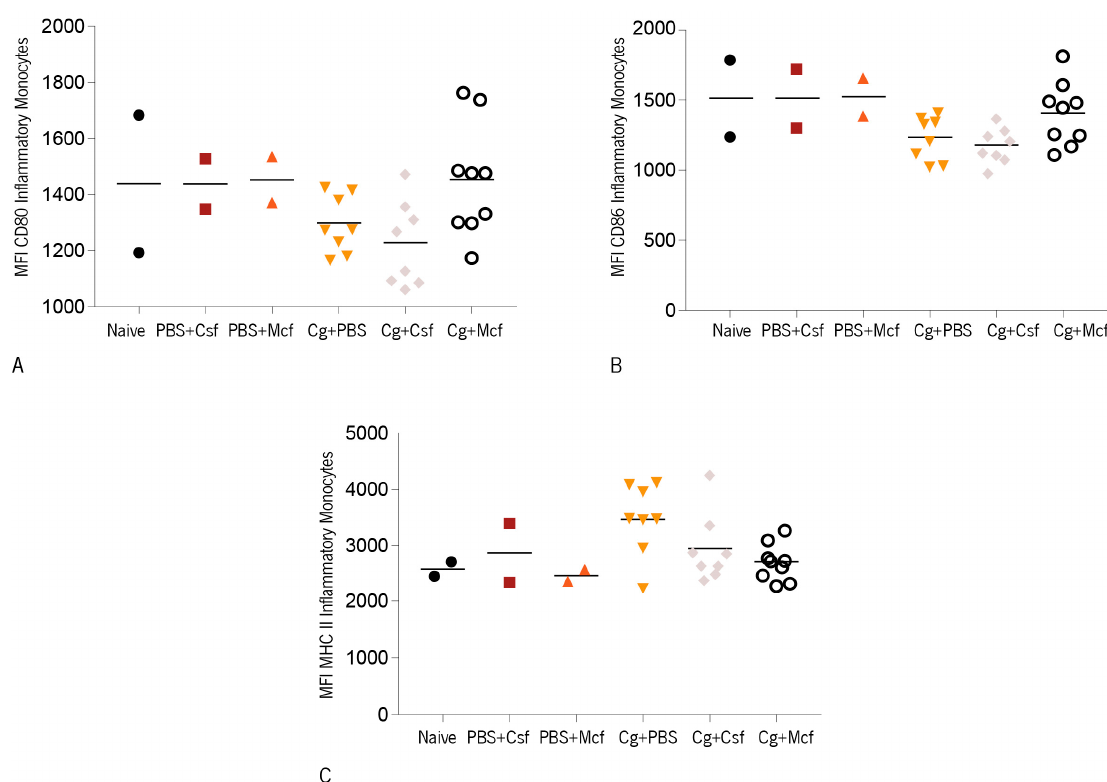
Figure 5. CD1 mice were challenged intravenously with 1 × 10 8 biofilm cells and then treated with PBS, caspofungin (Csf), or micafungin (Mcf). The obtained results are displayed as mean fluorescence intensities (MFI) due to antibody staining against ( A ) CD80, ( B ) CD86, and ( C ) MHC II on inflammatory monocytes. The numbers of animals per group were: controls (naïve; PBS + Csf; PBS + Mcf), n = 2; Cg + Csf, n = 8; Cg + Mcf, n = 8. Statistical differences among infected groups were evaluated using Kruskal–Wallis (Overall ANOVA P < 0.05) and post hoc Sidak’s multiple comparison tests. Cg— Candida glabrata ATCC2001.